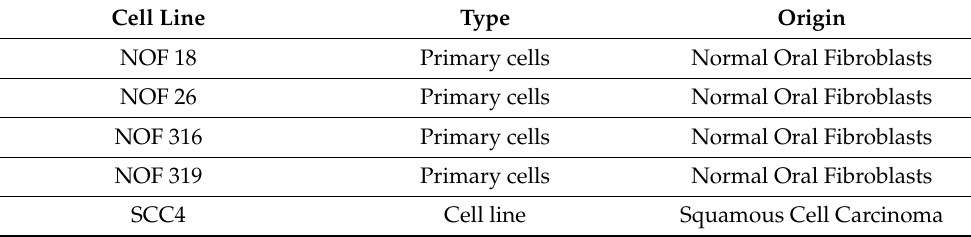
Table 1. Cells used in the study.